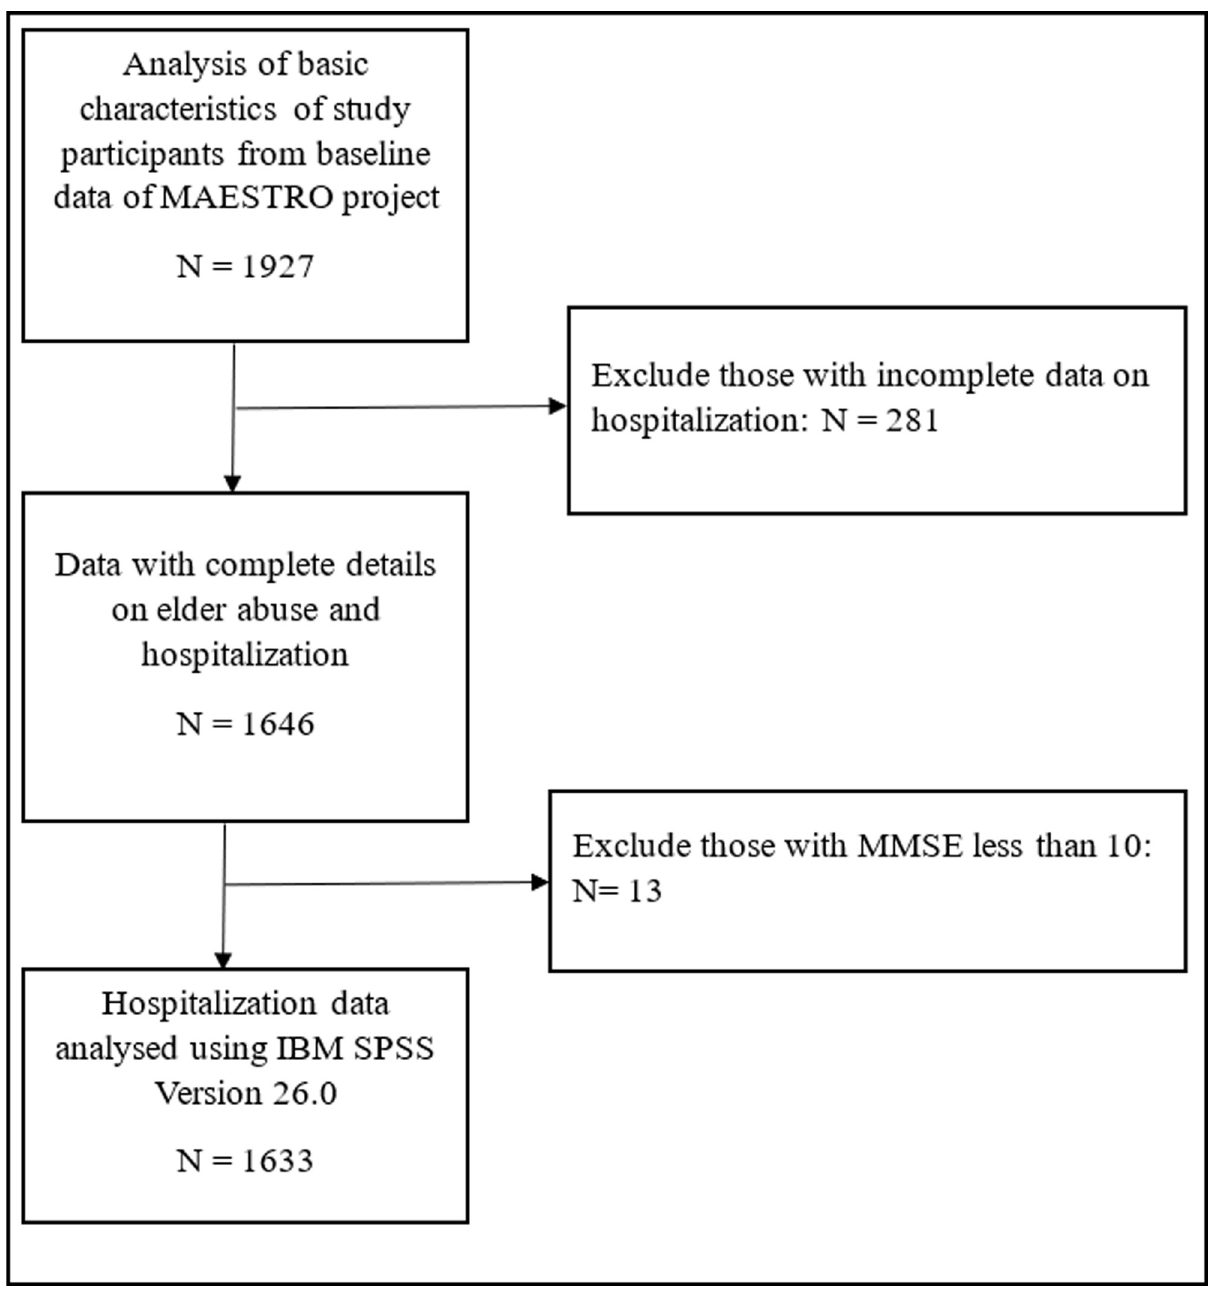
Fig 1. Data management